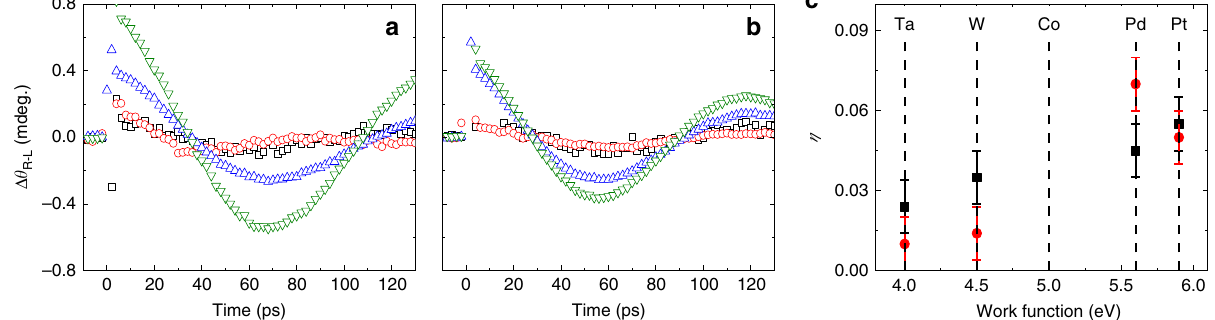
Fig. 7 Comparison with other HMs. The helicity-dependent Kerr rotation, difference between RCP and LCP, ( Δ θ R-L ) of a the sap/HM(5)/Co(3)/MgO(3) and b the sap/HM(5)/Cu(2)/Co(3)/MgO(3) samples, where HM is Ta (black squares), W (red circles), Pd (blue up-triangles), and Pt (olive down- triangles) at a photon ’ s energy of 1.58 eV. The y -axis of b is the same as that of a . c The quantum ef fi ciency ( η ) of the sap/HM(5)/Co(3)/MgO(3) (black squares), sap/HM(5)/Cu(2)/Co(3)/MgO(3) (red circles) samples. The η is calculated from dynamics Kerr rotation of a and b , static Kerr rotation (Supplementary Note 6), and light absorption (Supplementary Note 5). The vertical dashed lines indicate the work functions Ta, W, Co, Pd, and Pt at the (111) surface 32